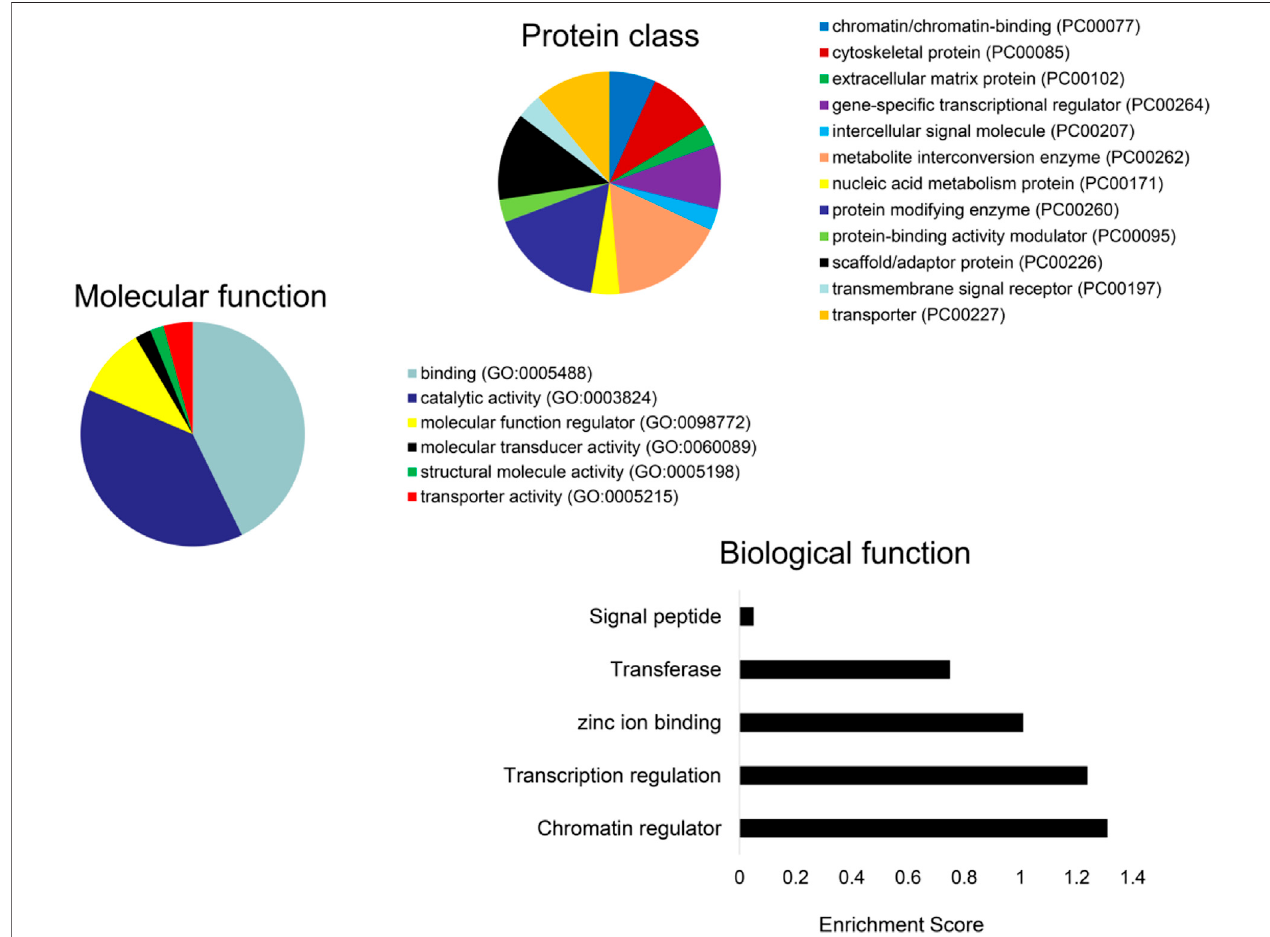
FIGURE 7 | Functional analysis of the DE-mRNAs. PANTHER analysis of the predicted protein class (A) and molecular function (B) of DE-mRNAs. (C) Enrichment of functional pathways of the DE-mRNAs using DAVID 6.7.